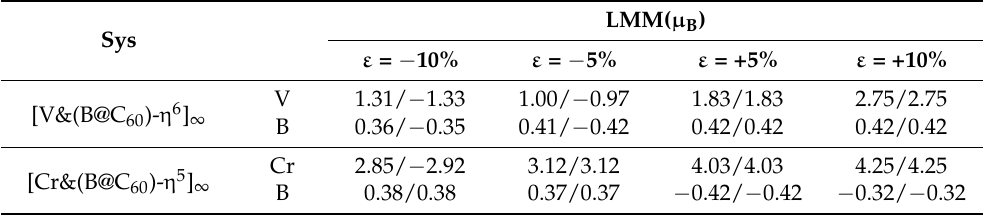
Table 2. Local magnetic moment of TM atom and B atom (LMM, µ B ) under different